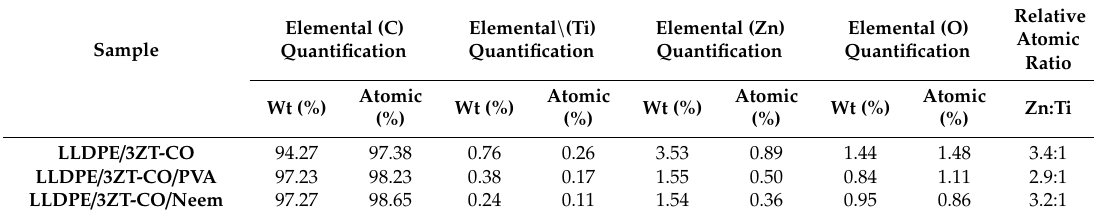
Figure 9. The elemental mapping of LLDPE composites ( a ) LLDPE / 3ZT-CO, ( b ) LLDPE / 3ZT-CO / PVA, and ( c ) LLDPE / 3ZT-CO / Neem. Table 3. The elemental mapping analysis of LLDPE composites by